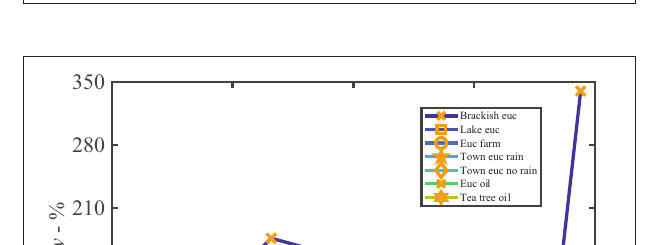
FIGURE 4 | A selection of adsorption isotherms including cabinet and brackish mangroves, along with the controls of the mangrove nutrient and NaCl with large sample size. The plot is the percentage moisture gain over the dry weight vs. relative humidity. The data are fitted with the GAB isotherm, as described in Equation (S1). The controls were formulated with a similar dry weight to the leaf wash samples. The parameters are described in Supplementary Table S2 and R 2 values are greater than 98.6%.